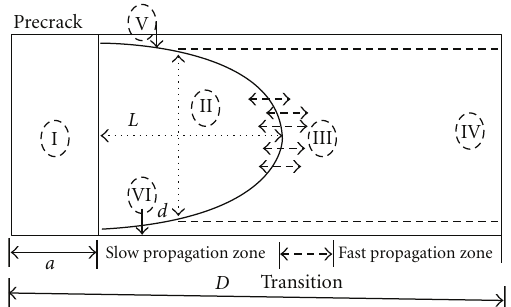
Figure 2: Schematic representation of fracture surface of HDPE or composite with a precrack (with permission of authors of [25]).